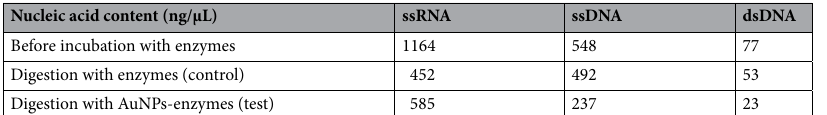
Nucleic acid content